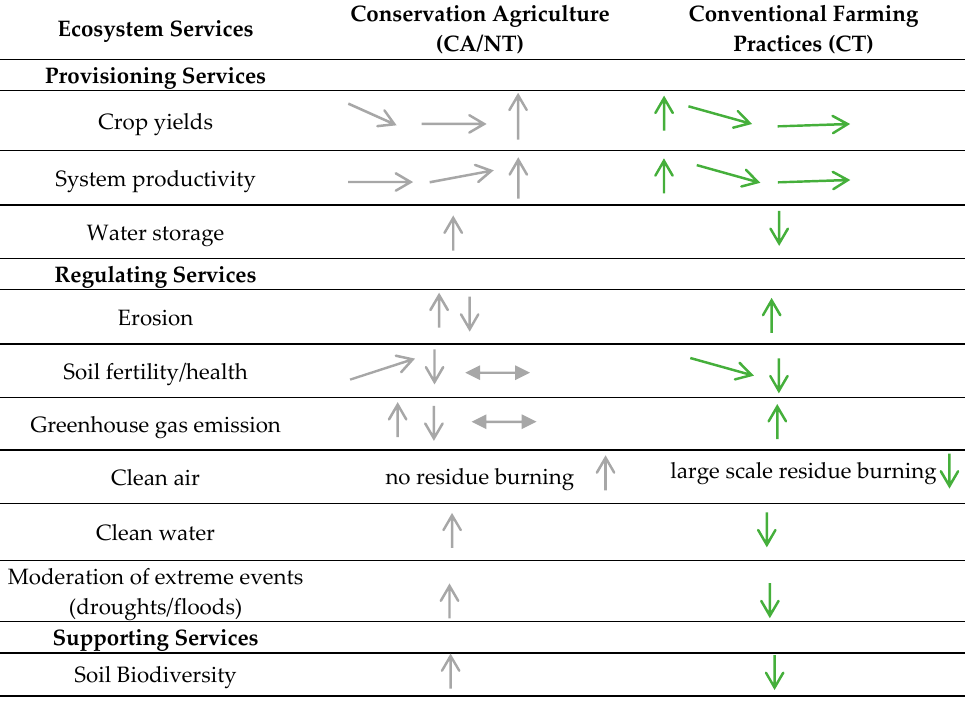
Table 1. Comparison of ecosystem services typically provided by conservation agriculture (CA/NT) versus conventional farming practices (CT).